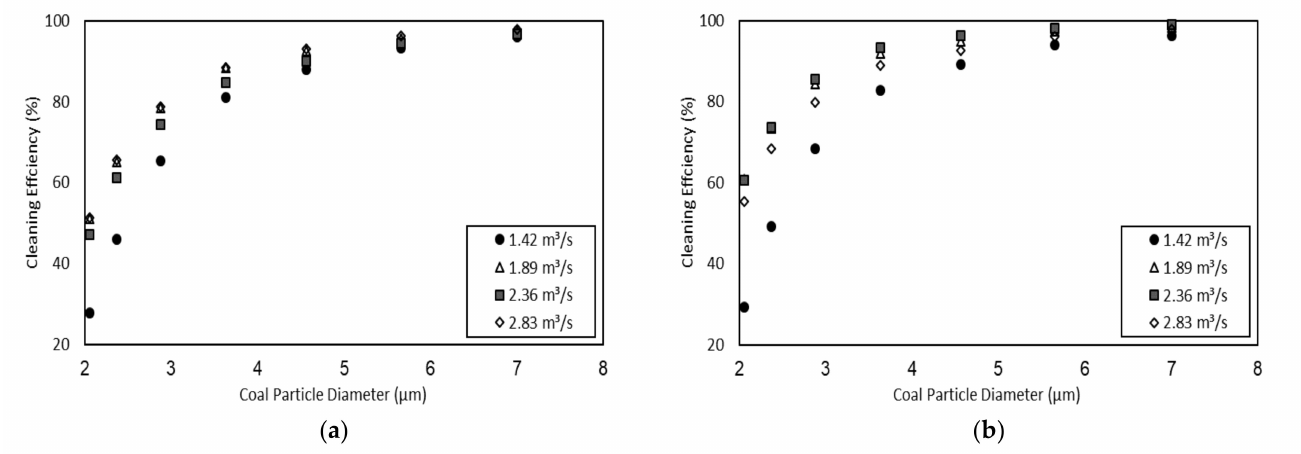
Figure 7. ( a ) Cleaning efficiency comparison of the filter with a water inflow rate of 18.9 L/min at different airflow rates; ( b ) cleaning efficiency comparison of the filter with a water inflow rate of 22.7 L/min at different airflow